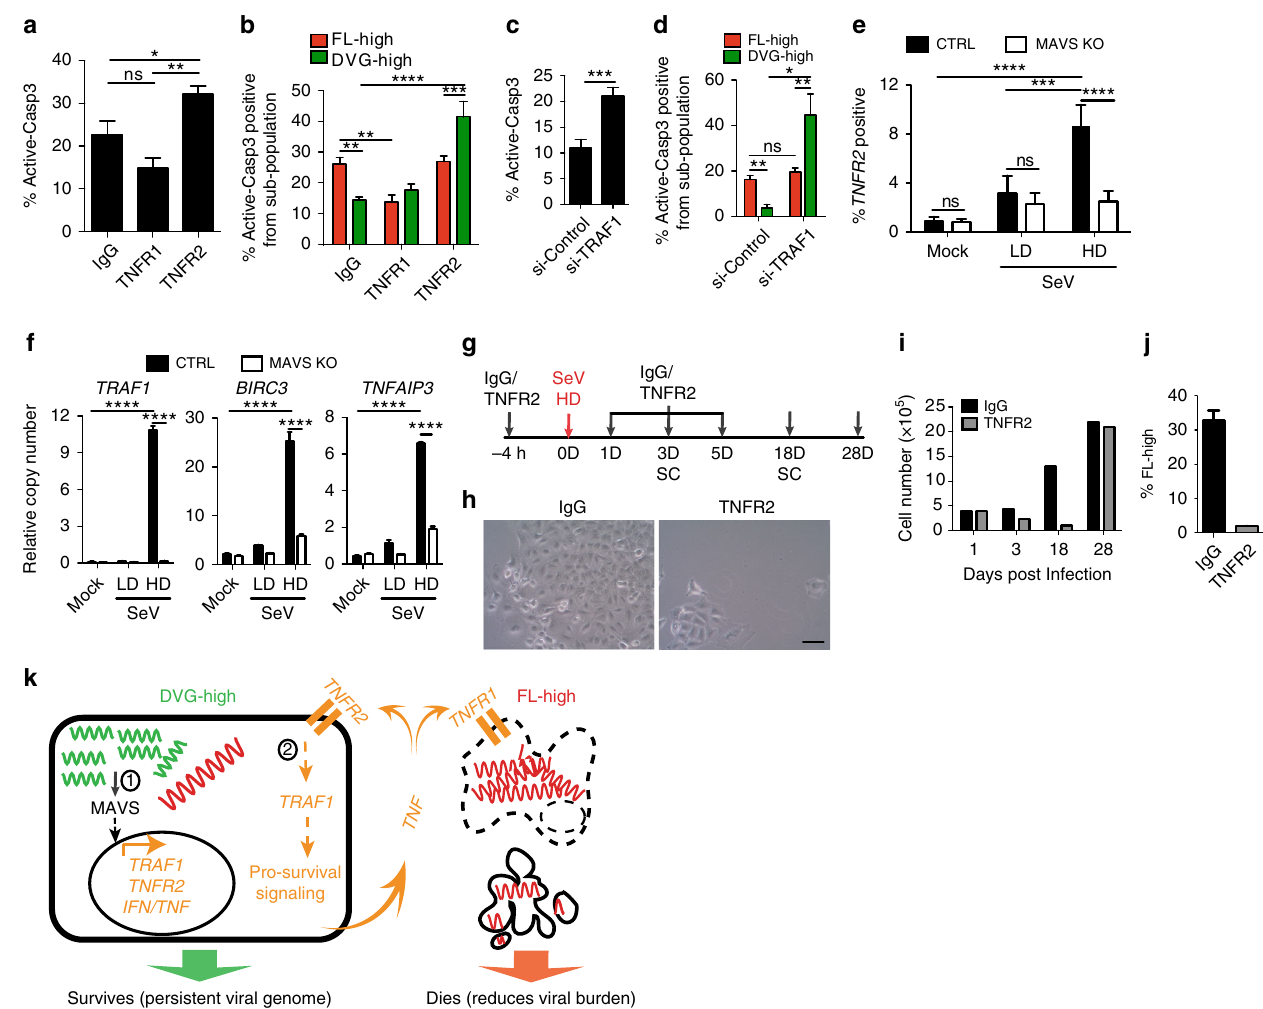
Fig. 6 The survival response of DVG-high cells is regulated by MAVS signaling. a , b SeV HD-infected A549 cells treated with either control-IgG, TNFR1 or TNFR2 neutralizing antibodies. a Percentage of active caspase-3 positive cells within the total cultures ( n = 4). b Percentage of active caspase-3 positive cells within FL-high and DVG-high cells in each condition ( n = 4). c , d A549 cells transfected with either control siRNA (si-Control) or TRAF1 siRNA (si- TRAF1 ) followed by SeV HD infection for 24 h. c Percentage of apoptotic cells within the total cell cultures ( n = 3). d Percentage of active caspase-3 positive cells within FL-high and DVG-high cells in each condition ( n = 3). e , f A549 CTRL and MAVS KO cells infected with SeV LD and HD (MOI = 1.5 TCID 50 per cell) for 24 h. e Expression of surface TNFR2 was quanti fi ed by fl ow cytometry ( n = 4) and f expression of cellular TRAF1 , BIRC3 , and TNFAIP3 (A20) mRNA by RT-qPCR. Data are expressed as copy number relative to the housekeeping gene GAPDH ( n = 4). g – j A549 cells treated with control IgG (IgG) or TNFR2 neutralizing antibodies (TNFR2) during SeV HD infection were sub-cultured (SC) for 28 days. g Illustration of the experiment schedule. h Bright fi eld images 18 days post SeV HD infection. One representative fi eld from each treatment is shown. Magni fi cation: ×20. Scale bar = 20 μ m. i Total cell numbers during the infection time course. j Percentage of FL-high cells quanti fi ed by RNA FISH-FLOW 28 days post infection. Experiments were repeated twice and one representative experiment is shown. k Schematic representation of proposed model. DVGs-high cells engage a MAVS-dependent antiviral pathway that drives the antiviral response and the apoptosis of neighboring cells through the production of TNF α (denoted 1), while protecting the cytokine-producing cell from death through a TNFR2/TRAF1 mediated mechanism (denoted 2). Data are shown as ± s.e.m. * P < 0.05, ** P < 0.01, *** P < 0.001, and **** P < 0.0001 by one-way ( a ) or two-way ( b , d , e , f ) ANOVA with Bonferroni ’ s post hoc test, or unpaired t -test c . ns, non-signi fi cant. See